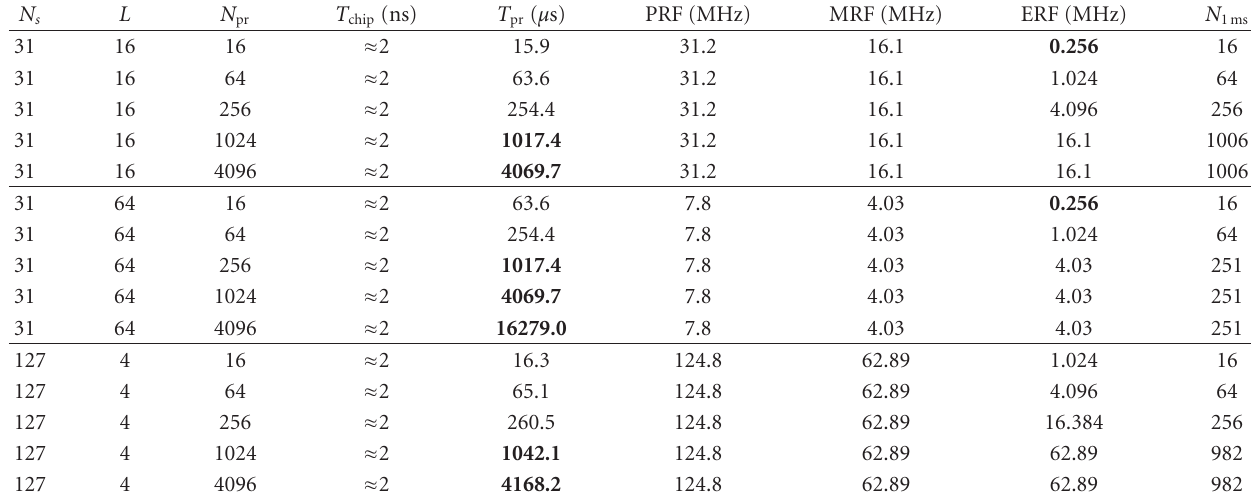
Table 1: Preamble